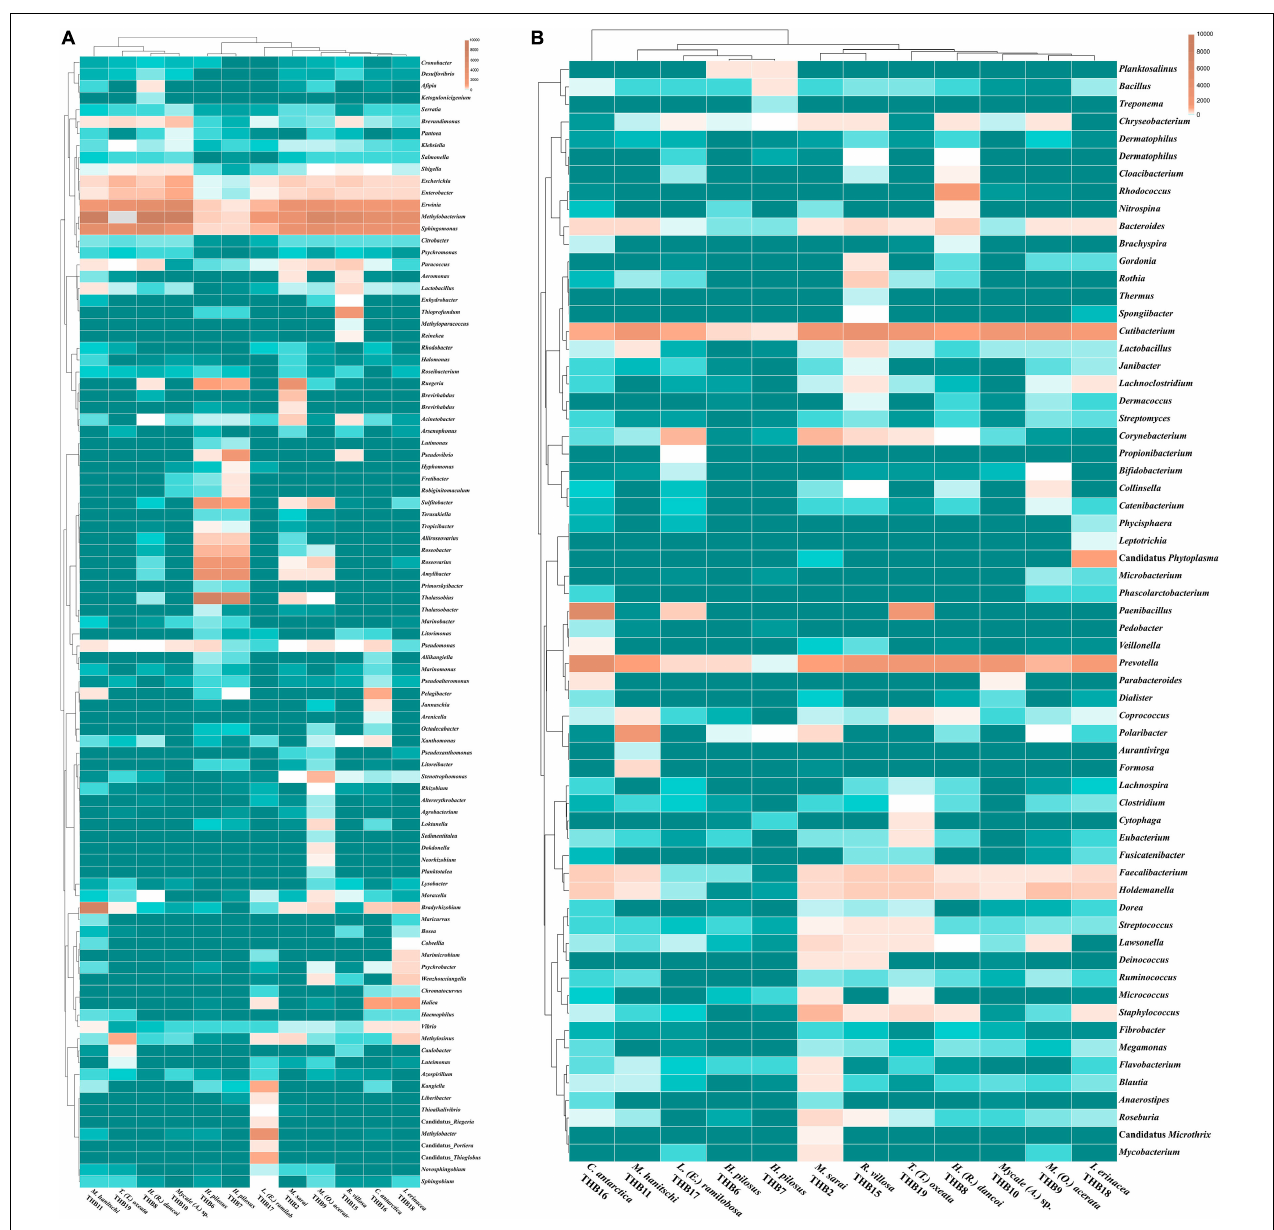
FIGURE 3 | Heatmaps showing the genera distribution and clustering based on relative abundances detected in sponge samples. Color blocks represent the relative abundance of genera. More dark indicates a higher relative abundance. (A) Proteobacterial genera. (B) Genera belonging to other phyla or